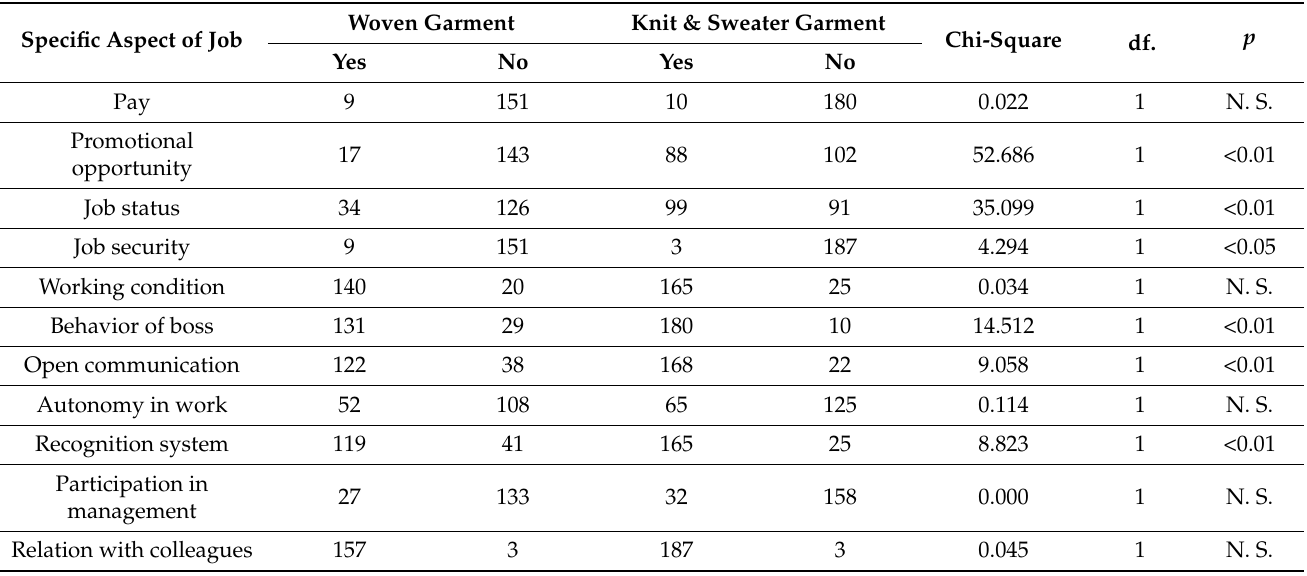
Table 8. Composite chi-square for satisfaction and dissatisfaction with specific professional aspects based on the type of organization (woven and knit and sweater garment, N = 350).